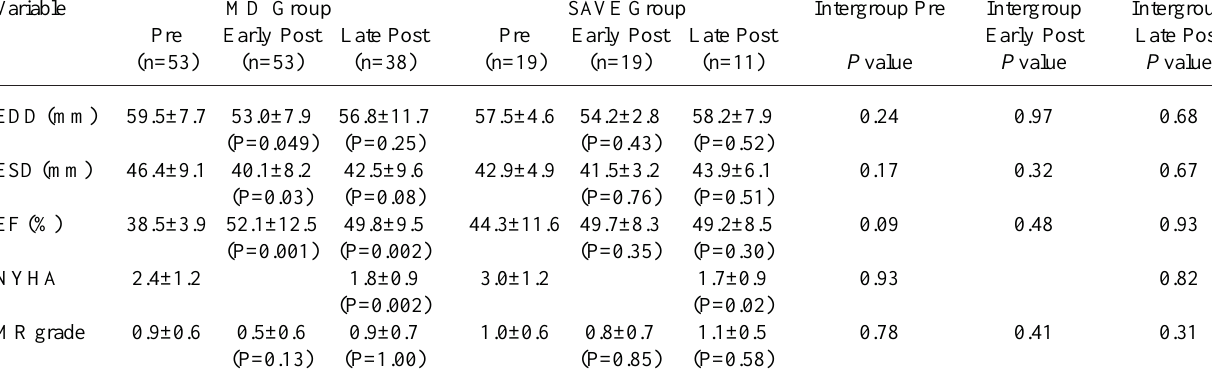
Table 2. Baseline and late follow up NYHA and echocardiographic data. Variable